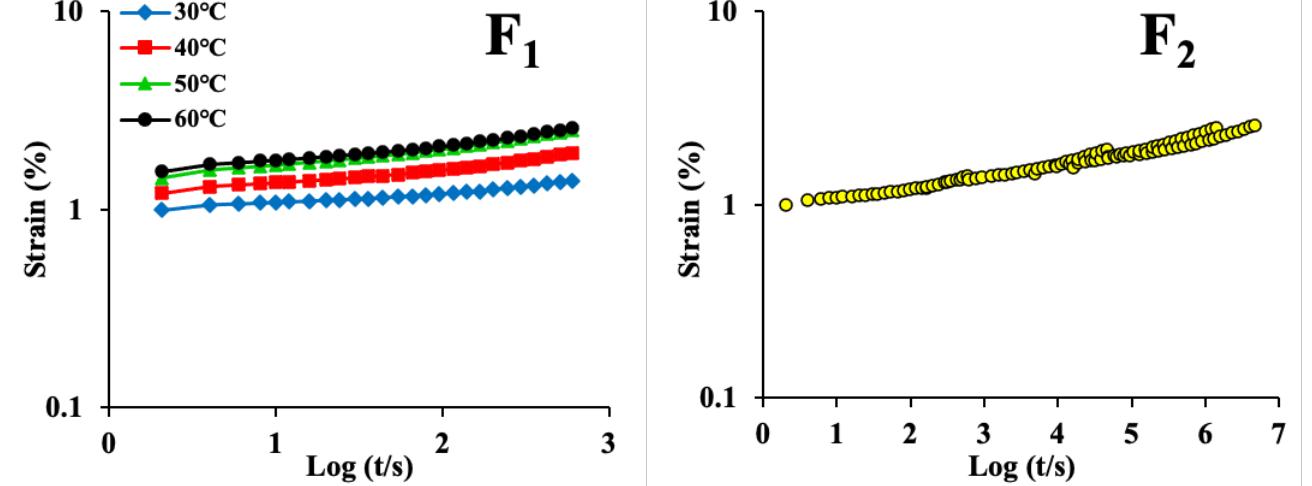
Figure 4. The left-hand graphs show logarithmic plots of creep data for maize kernels, while the right-hand graphs are the corresponding master curves for maize kernels ( A 1 , A 2 ) — ND; ( B 1 , B 2 ) — HVD 35 °C; ( C 1 , C 2 ) — HVD 45 °C; ( D 1 , D 2 ) — HVD 55 °C; ( E 1 , E 2 ) — HVD 65 °C; ( F 1 , F 2 ) — HVD 75 °C.